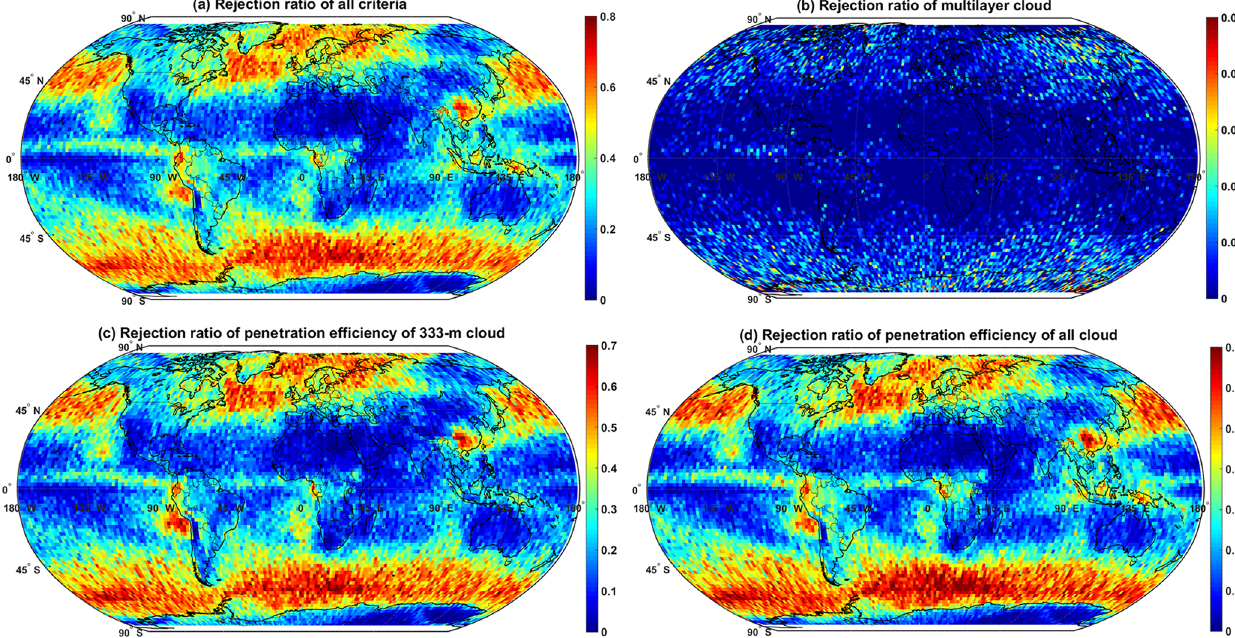
Figure A6. (a) Geographic distribution of rejection ratio of all criteria (multilayer cloud, penetration efficiency of 333m resolution cloud, and penetration efficiency of all resolution cloud) on a 2 ◦ × 2 ◦ latitude–longitude grid in 2014 and 2017. Panels (b) , (c) , and (d) are the same as panel (a) but for multilayer cloud, penetration efficiency of 333m resolution cloud, and penetration efficiency of all resolution cloud,